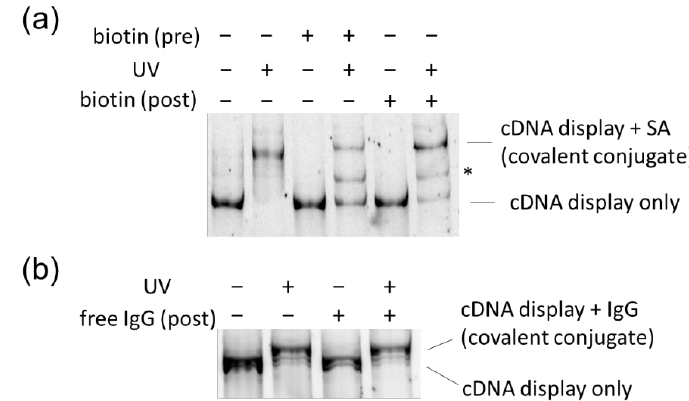
Figure 4. Affinity-dependent photocrosslinking between cDNA display molecules and target proteins. ( a ) Crosslinking of cDNA display encoding SA-binding peptide (SBP) and SA labeled with tag DNA. They were incubated with and without biotin, and UV irradiation was performed before PAGE analysis. For lanes 5 and 6, biotin was added after irradiation. The gel was visualized with FAM that was attached to the cDNA display. The asterisk (*) indicates an uncharacterized sub-band. ( b ) Crosslinking of cDNA display encoding the B domain of protein A (BDA) and immunoglobulin G (IgG). For lanes 3 and 4, free IgG was added after irradiation.